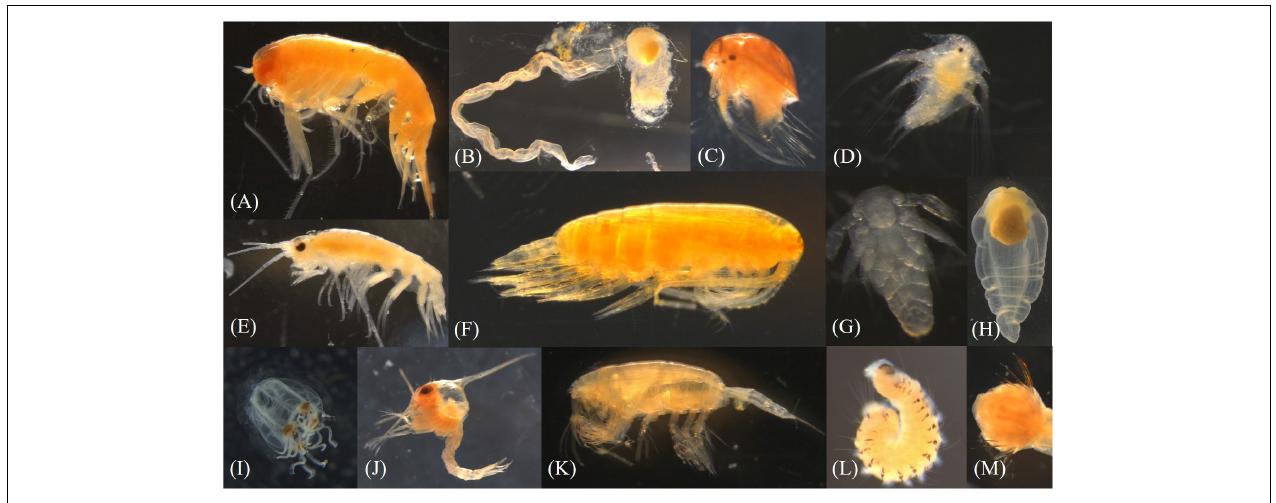
FIGURE 7 | Pictures of under-ice fauna (A) Themisto sp., (B) Appendicularia, (C,D) Cirripedia, (E) Apherusa glacialis , (F) Calanus sp., (G) Nauplius, (H) Clione limacina , (I) Hydrozoa, (J) Zoaea larvae, (K) Paraeuchaeta sp., (L) Polychaeta, (M) Chaetognatha (head). Photographs by Julia